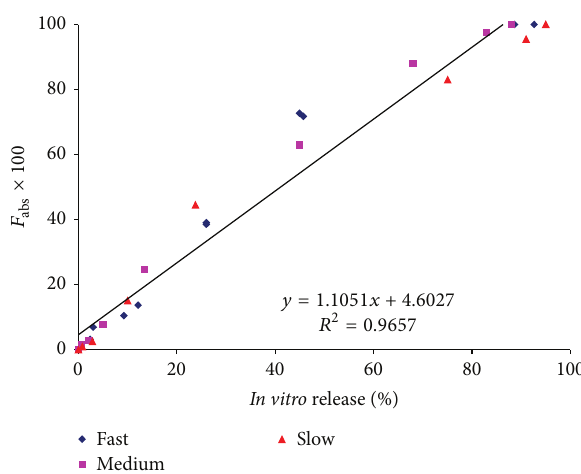
Figure 9: Pooled IVIVC for Olanzapine PLGA microsphere formu- lations using Nelson-Wagner method (Level A).